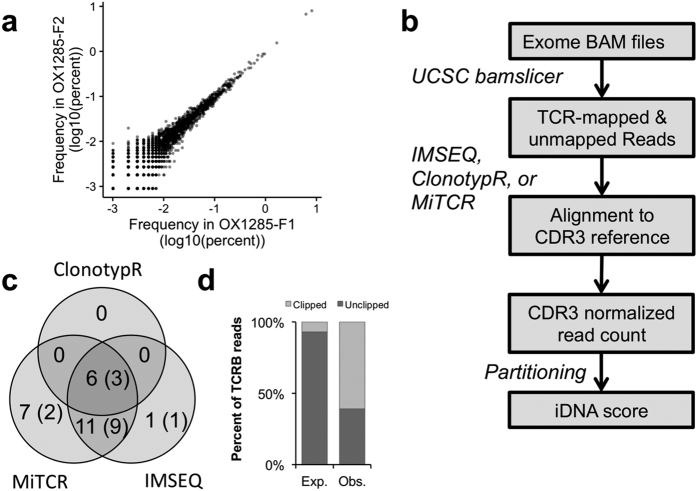
Identification of CRD3 reads in whole-exome data.(a) Clonotype abundance determined by deep repertoire sequencing (ImmunoSeq) in two adjacent breast cancer tissue sections. (b) Workflow to extract and identify rearranged CDR3 reads from exome datasets. (c) Comparison of the number of CDR3 reads identified by each clonotyping tools. The number in parenthesis indicates the subset of clonotypes also identified by deep repertoire sequencing. (d) Fraction of clipped reads mapped to the TCR region in the exome BAM file. The expected is estimated from all mapped reads in the exome.